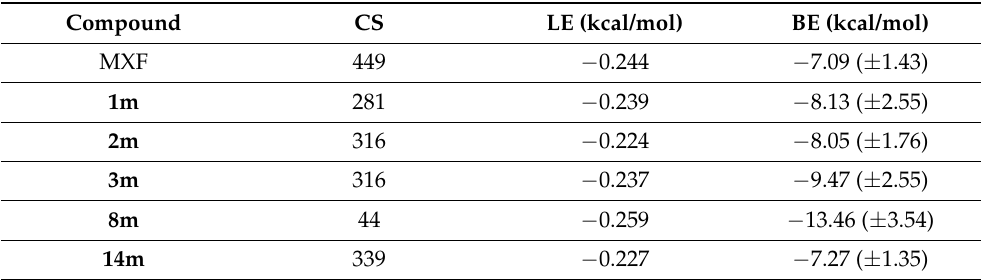
Table 7. DNA gyrase binding data based on docking results for MXF and its derivatives. Data obtained for docking of ligands to crystal structure PDB ID: 5BS8 (DNA gyrase in complex with DNA and MXF)